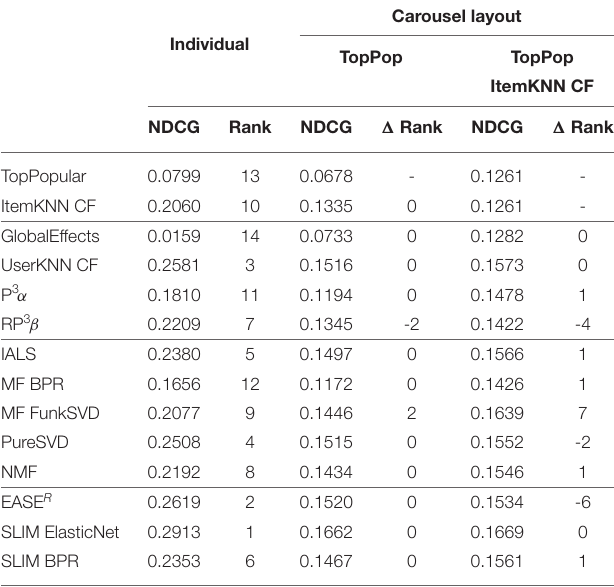
TABLE 4 | Comparison of the NDCG at 10 value and overall model ranking for NetflixPrize. Carousel layout Individual TopPop TopPop ItemKNN